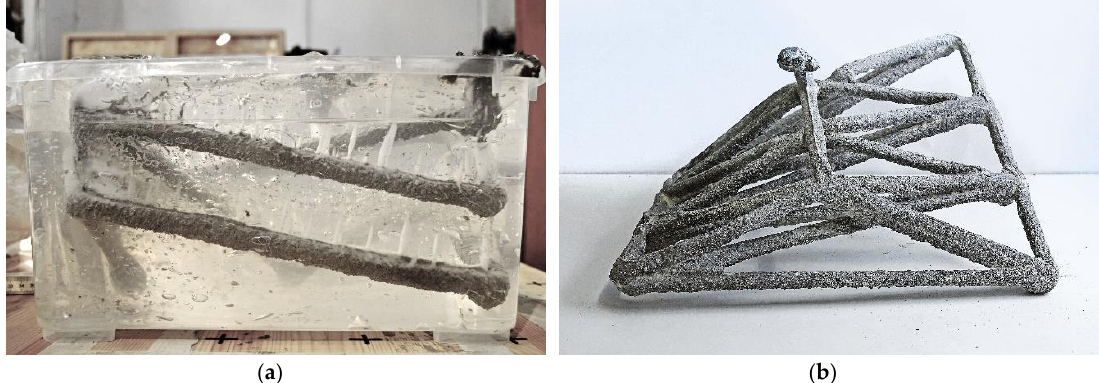
Figure 6. Results of the calibration process: ( a ) a spiraling geometry printed in gel; ( b ) a more complex geometry printed in a 1:1 gel-sand suspension.